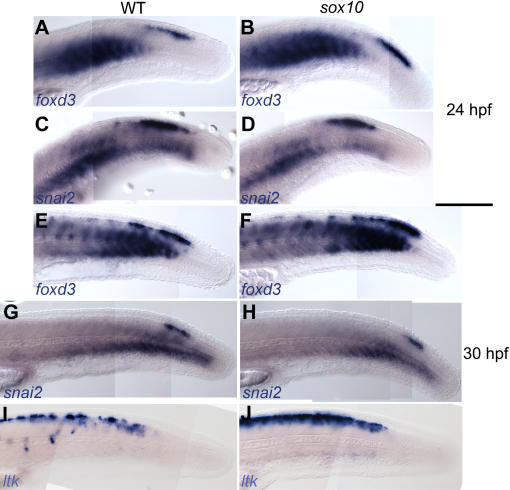
Early NC markers are unaffected in sox10 mutants.WT (A,C,E,G,I) and sox10t3 mutants (B,D,F,H,J) showing foxd3 (A,B,E,F) or snail2 (C,D,G,H) or ltk expression at 24 (A–D) and 30 hpf (E–J).